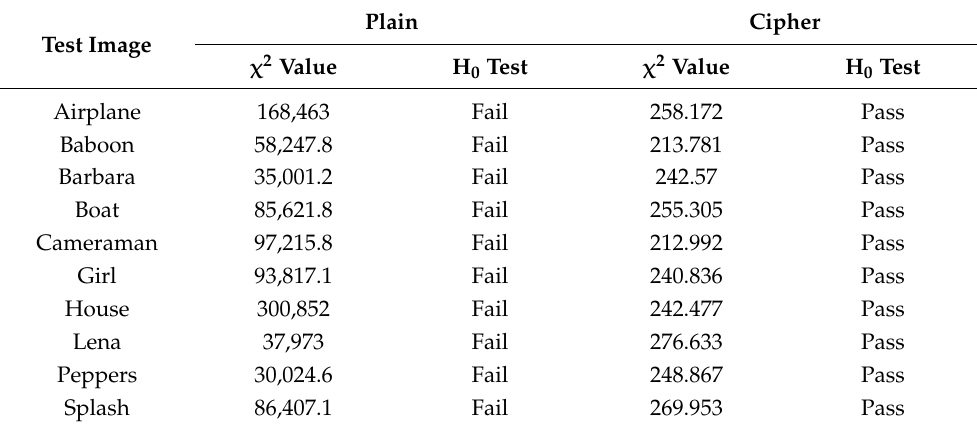
Table 4. Chi-square test: Pixel distribution